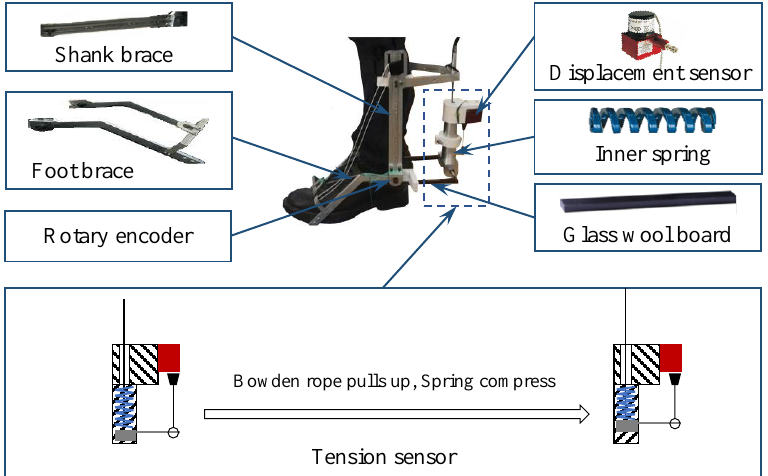
Figure 6. Schematic diagram of exoskeleton wearing